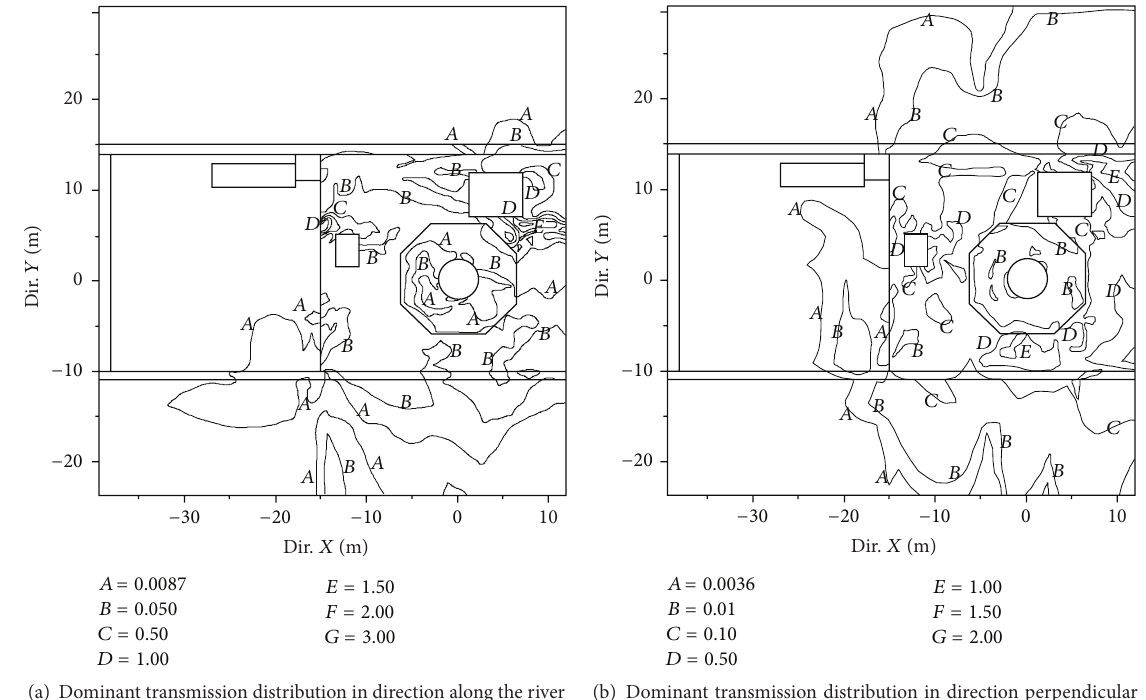
Figure 5: Dominant transmission path at 1288.8